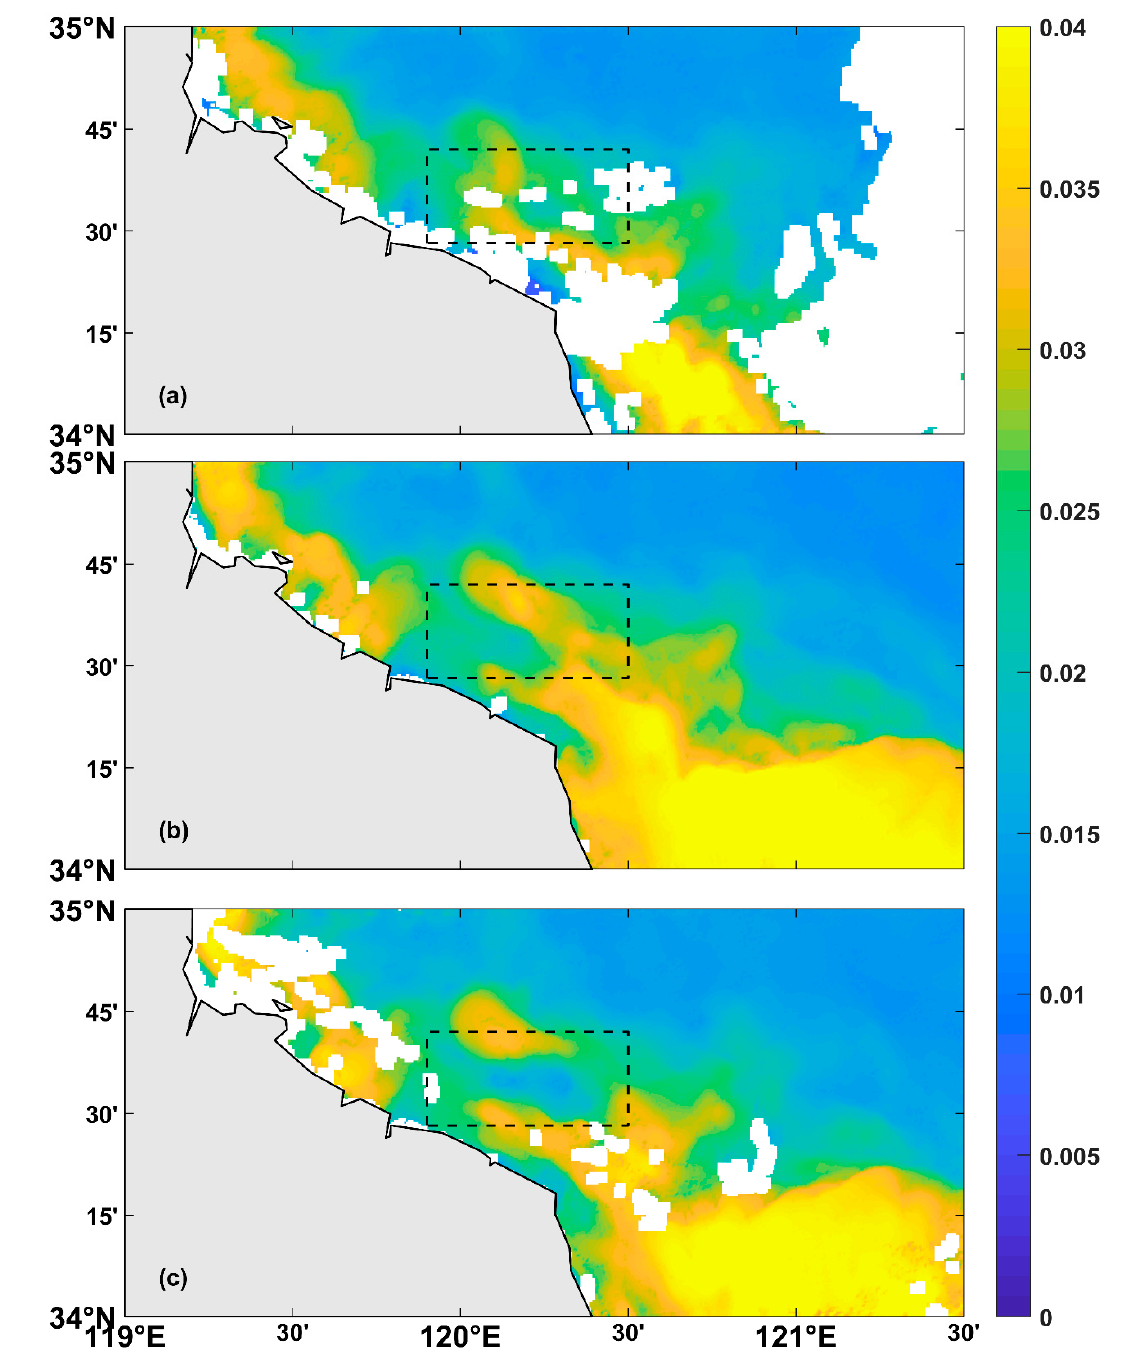
Figure 3. Three examples of MODIS color index (CI) fields at ( a ) 0535 UTC on 10 Jul 2017, ( b ) 0440 UTC on 11 Jul 2017 and ( c ) 0525 UTC on 12 Jul 2017. The submesoscale anticyclonic eddies are indicated by the black dashed lines. The values on the legend represent the relative magnitudes of CI, with higher values indicating more turbid waters. Note that, for the three days shown here, MODIS Chl-a images do not show valid data in most areas.